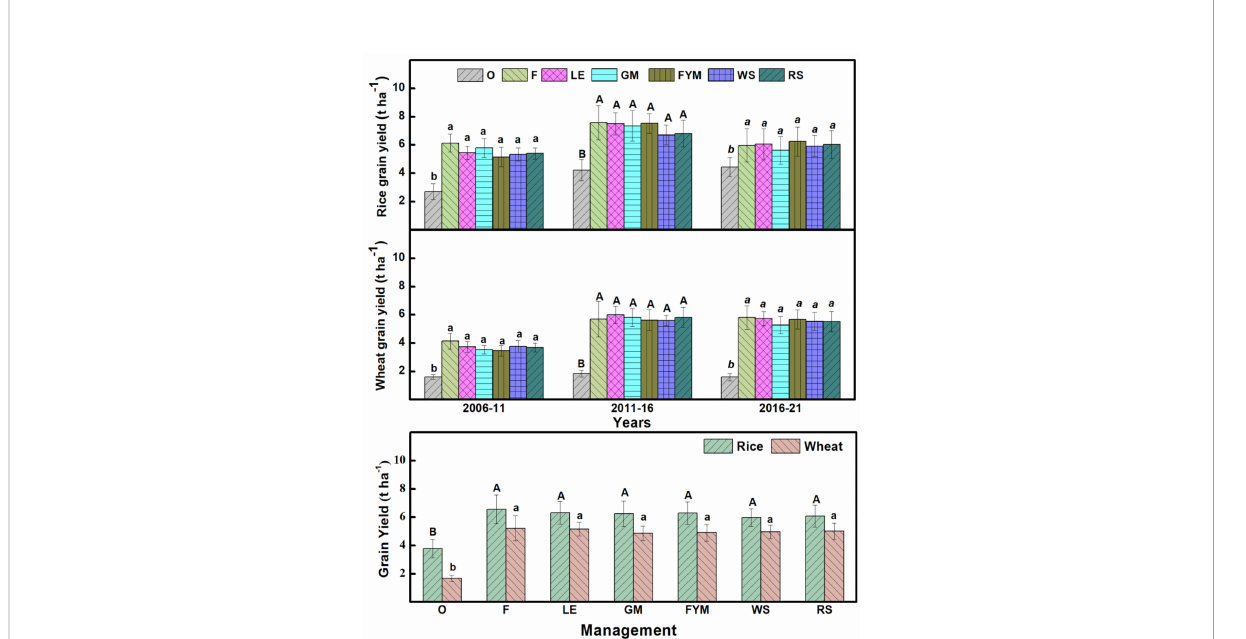
FIGURE 5 Trends in the grain yield (t ha -1 ) of rice and wheat crop during 15 years (2006-2021) of different nutrient management. Error bars denote ± 1SD. Different letters indicate signi fi cant differences (P ≤ 0.05). Refer to Figure 2 for the description of